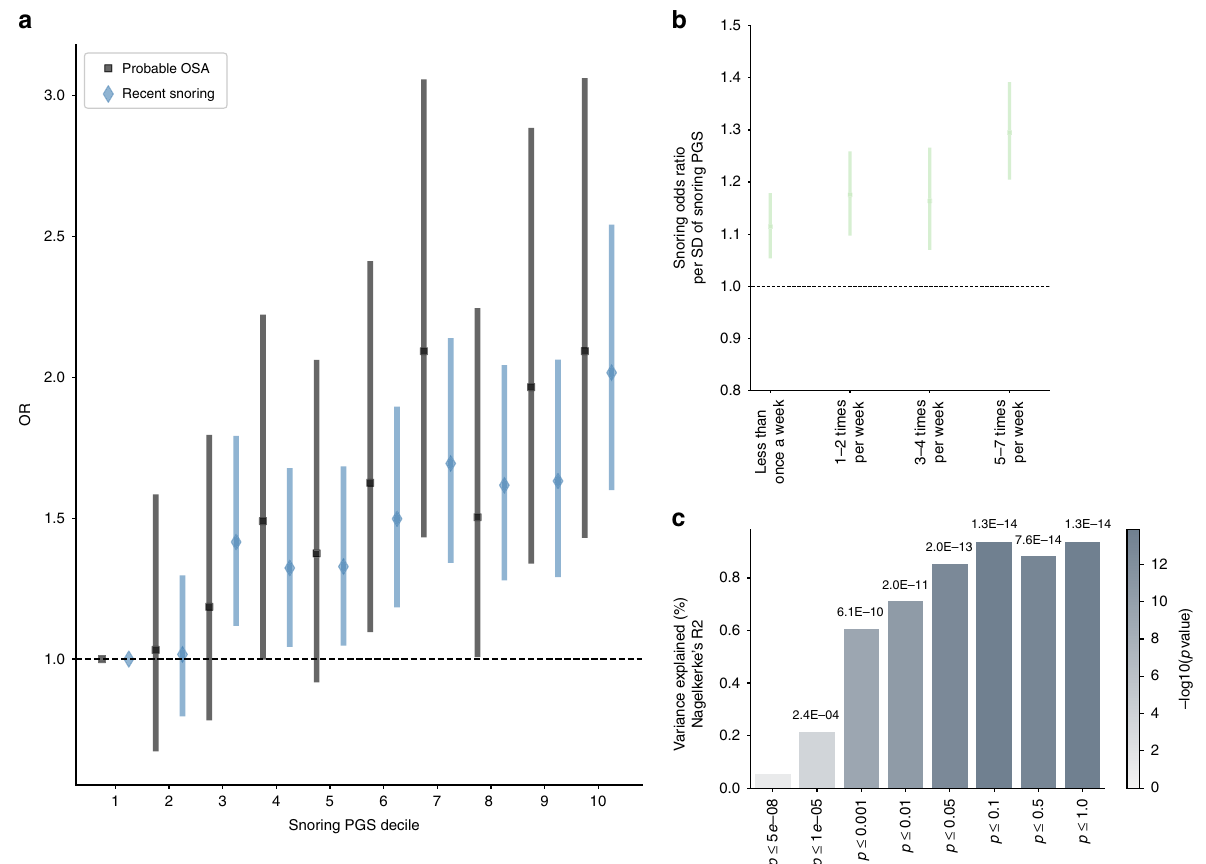
Fig. 6 Polygenic scores predict snoring and probable apnoea in an independent sample. a Forest plot showing the odds ratios (and 95% CI) by decile of polygenic score (PGS) for snoring from the UK Biobank discovery sample (relative to the bottom decile = 1) for recent snoring and probable sleep apnoea measured in an independent target sample of ~8000 unrelated Australian adults from the Australian Genetics of Depression Study (AGDS). b Snoring PGS predicting different snoring frequencies reported in AGDS target sample. c Variance of recent snoring in AGDS explained by PGS calculated from UK Biobank summary statistics. The x -axis represents the p -value threshold used for variant inclusion during genetic scoring; the y -axis represents the amount of variance explained (change in Nagelkerke R 2 ). The colour of each bar represents the signi fi cance of the association between the PGS and recent snoring ( − log10 p -value), while the exact p -value (Wald ’ s test) is shown above each